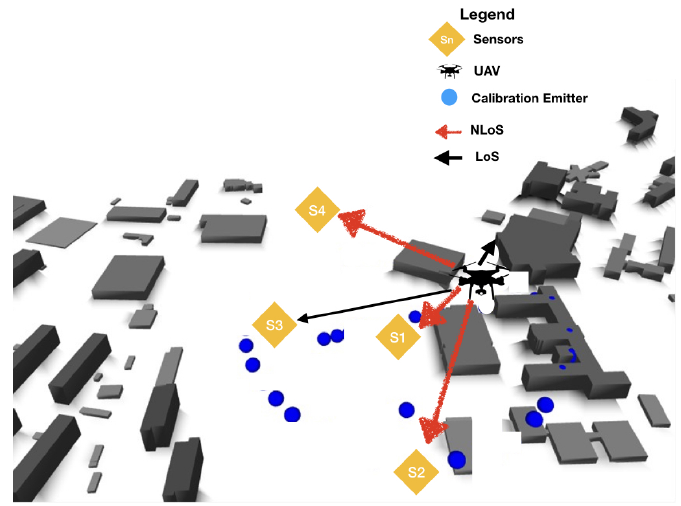
Figure 11. TDOA location scenario in